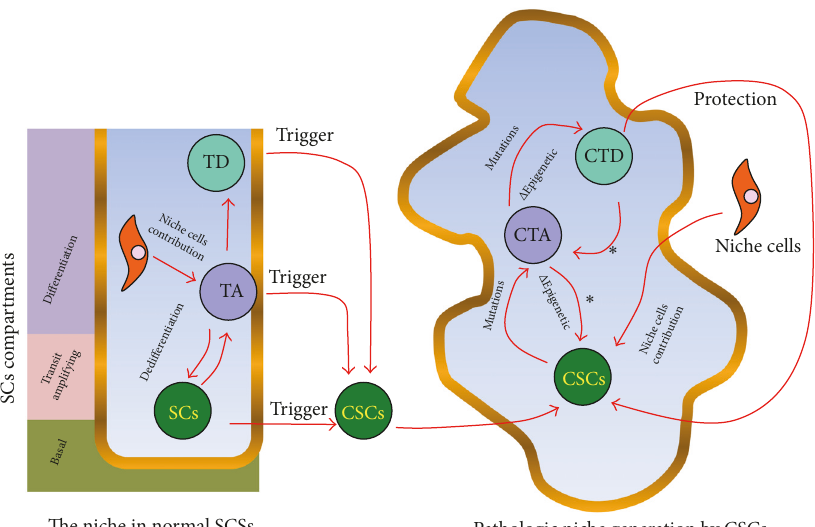
Figure 1: The origin of Cancer Stem Cells (CSCs) and Stem Cells (SCs) involvement in the generation of pathological cell hierarchies in tumors. In normal Stem Cell Systems, SCs located at the basal compartment generate committed progenitors (through asymmetrical divisions) which become spatially relocated to the transit-amplifying (TA) compartment. There, progenitors actively divide to produce differentiated daughter cells that carry on the normal physiology of the organ. Under physiological emergencies associated with SC loss, TA cells can dedifferentiate to reload the SC pool. Certain stressful triggers (i.e., chronic inflammation, ROS accumulation, and aging) can promote the transformation of cells in the system and generate CSCs or cancer initiating cells. CSCs remodel the niche and produce a pathological cancer microenvironment and associated hierarchy (pathological Stem Cell System) that resembles the original normal Stem Cell Systems (SCSs). The tumor is a very heterogeneous entity with cells that have accumulated mutations and epigenetic profile changes to secure CSCs survival and thriving. Features typical of SCSs such as niche support, SCs stemness, and dedifferentiation paths ( ∗ ) remain in the tumor environment. SCs = Stem Cell; TA = transit-amplifying progenitor; TD = terminally differentiated cell; CSC = Cancer Stem Cell; CTA = cancer transit-amplifying progenitor; CTD = cancer terminally differentiated